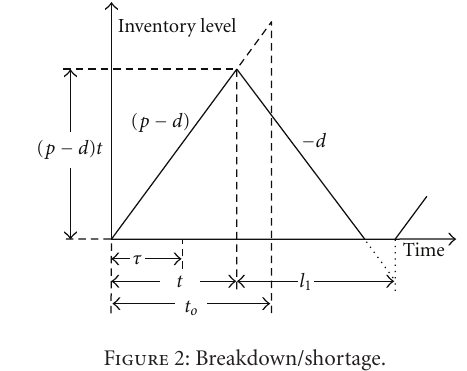
Figure 2: Breakdown/shortage.